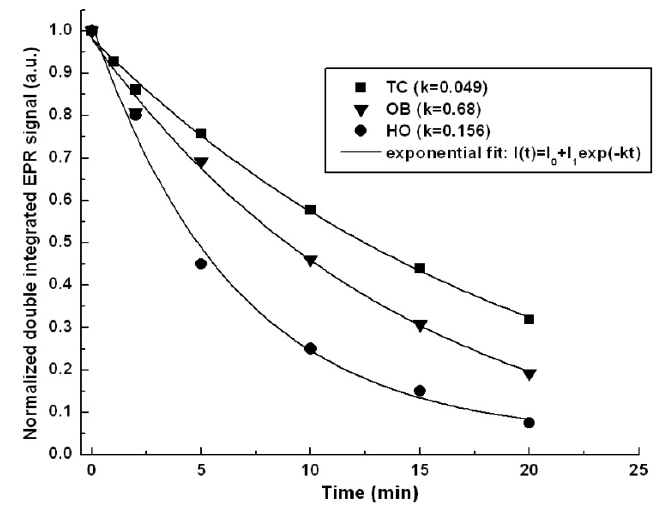
Figure 4. The rate of reaction between antioxidant compounds and TEMPO radical.